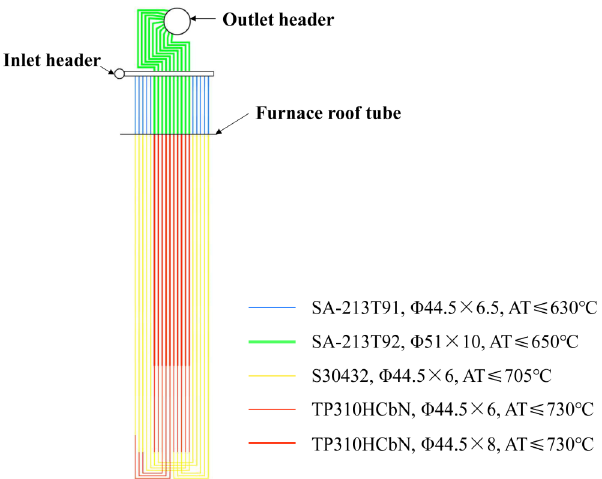
Figure 2. The metal material, pipe specifications, and allowable temperatures of the